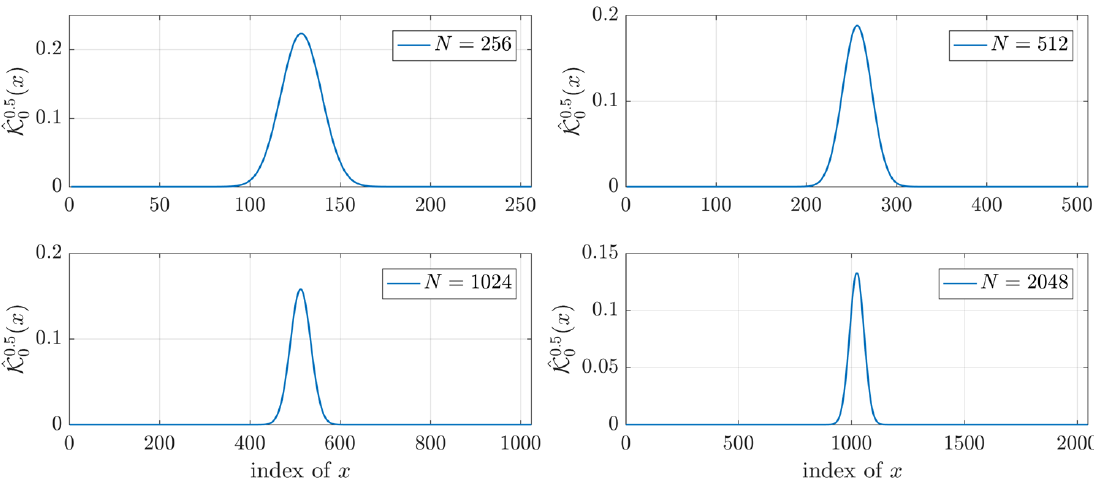
( x ) for different values of polynomial size. Figure 2. Plot of K 0.5 0